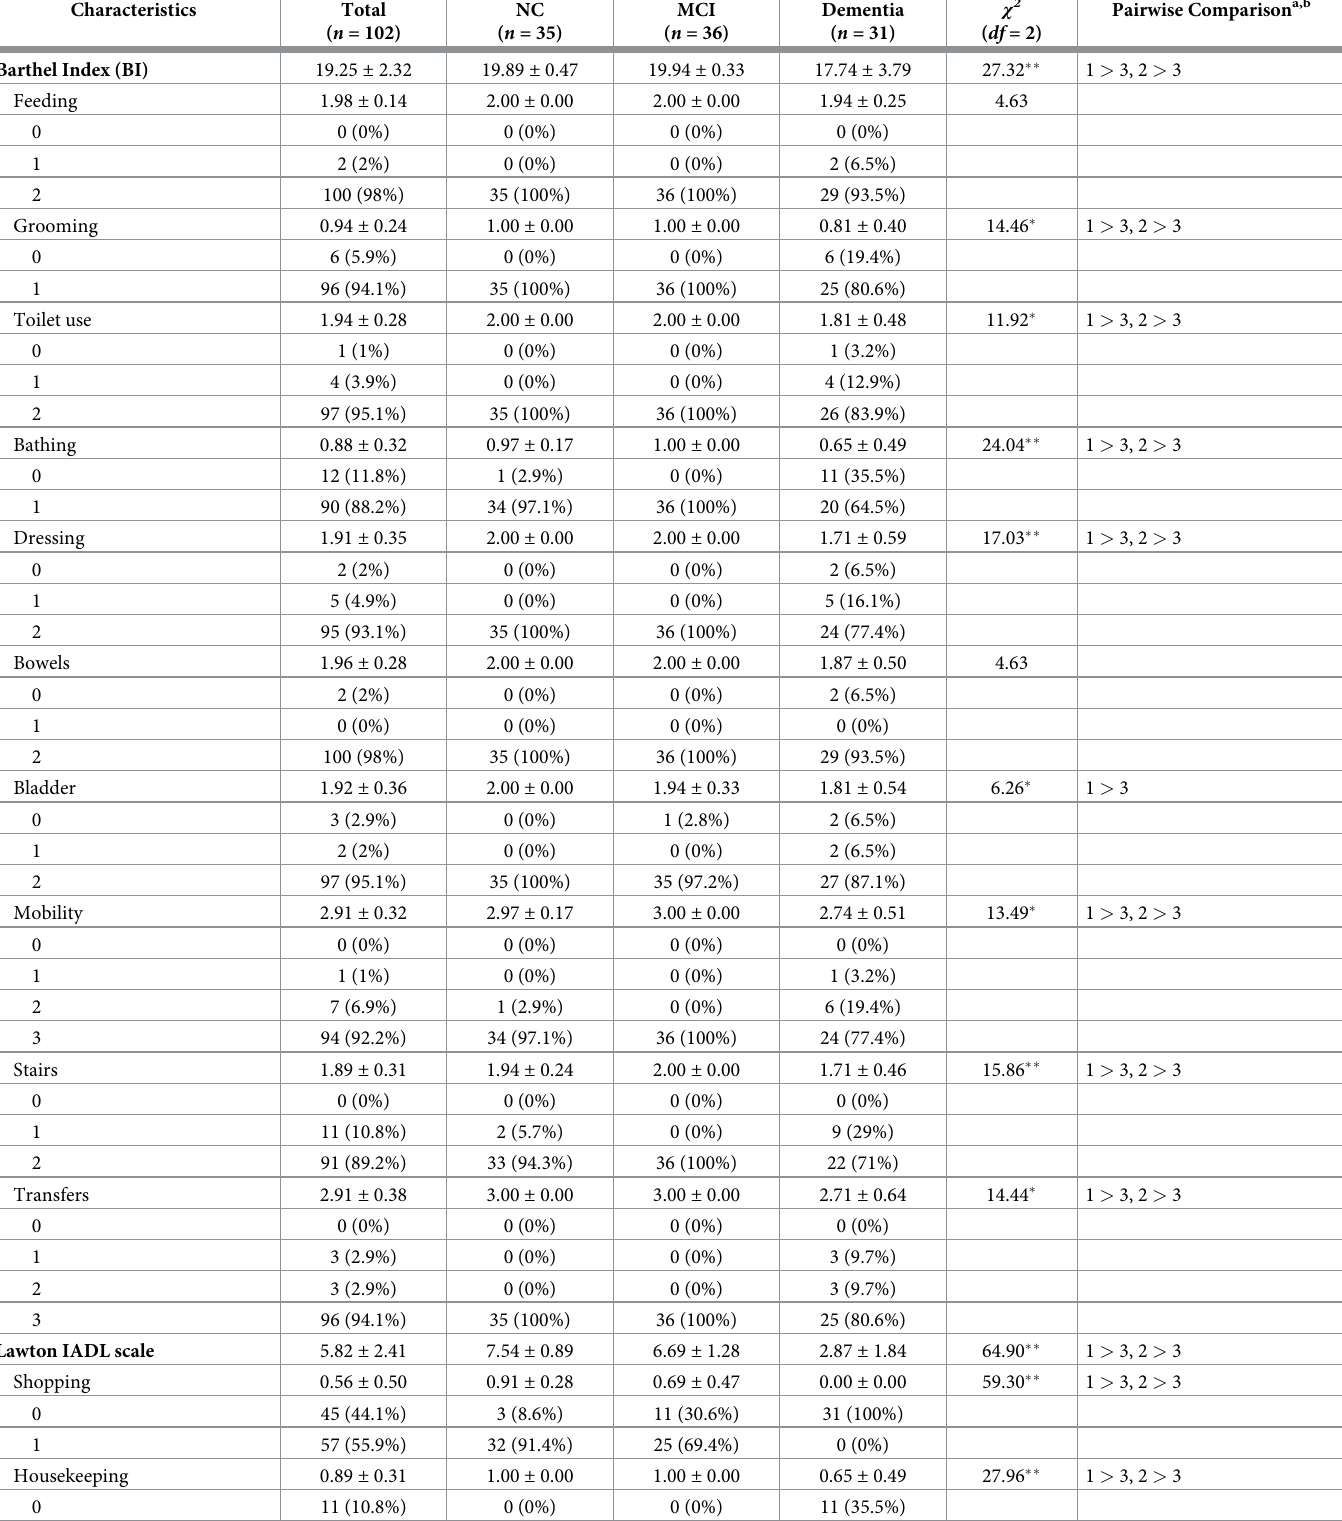
Table 3. Univariate analysis of the basic and instrumental activities of daily living functions among the subjects of NC, MCI, and dementia.